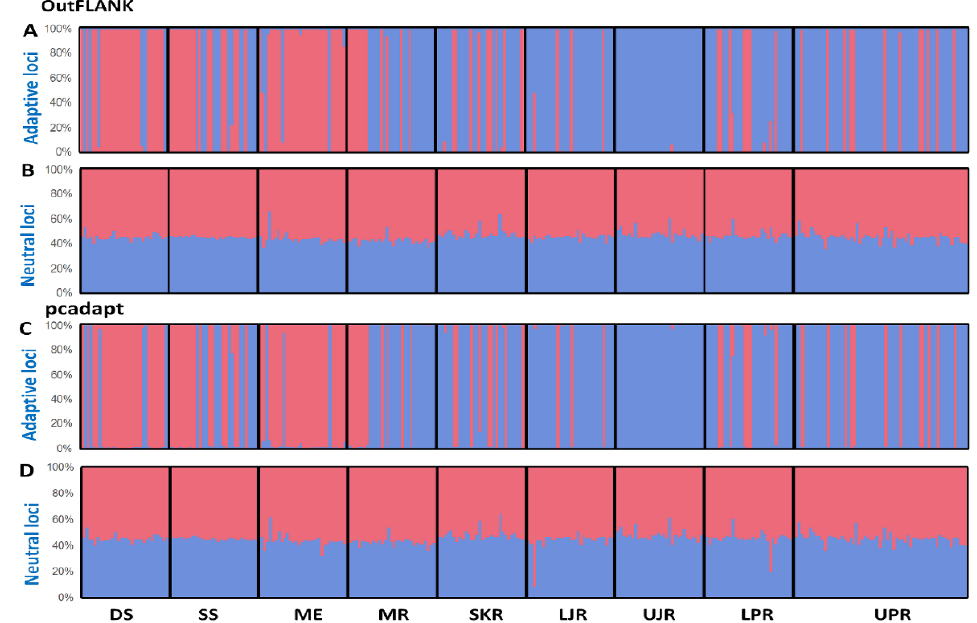
Figure 7. Bayesian STRUCTURE bar plot, based on the ( A , B ) F ST OutFLANK approach for the 74 putatively adaptive SNP loci ( A ) and 15,379 putatively neutral SNP loci ( B ); and ( C , D ) pcadapt approach for the 449 putatively adaptive panel of SNP loci ( C ) and 15,004 putatively neutral panel of SNP loci ( D ). Black lines separate the individuals of di ff erent populations. Each vertical line represents an individual. The colors represent the proportion of inferred ancestry from the K ancestral populations. Based on the delta K statistic, the best-supported number of a posteriori genetic clusters was K = 2 for the standard admixture model. DS, deep sea; SS, shallow sea; ME, Meghna estuary; MR, Meghna river; SKR, Surma–Kushiara river; LPR, lower Padma river; UPR, upper Padma river; LJR, lower Jamuna river; UJR, upper Jamuna river.